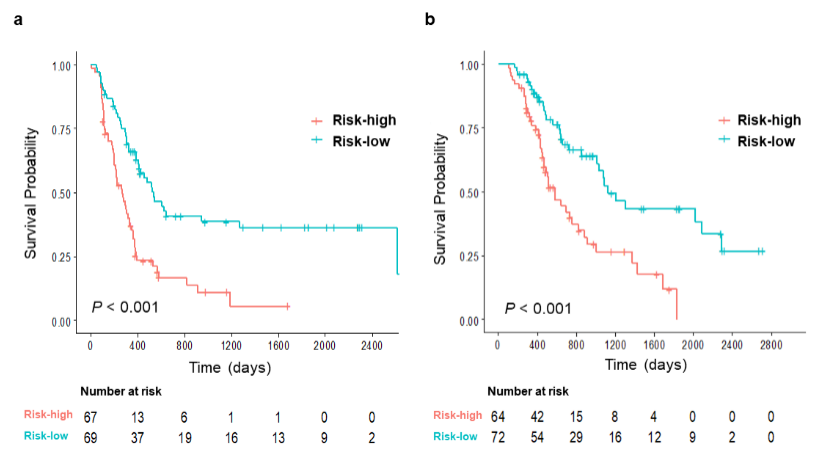
Figure 4. Risk stratification according to the calculated probability of five-year (A) disease-free survival and (B) overall survival.